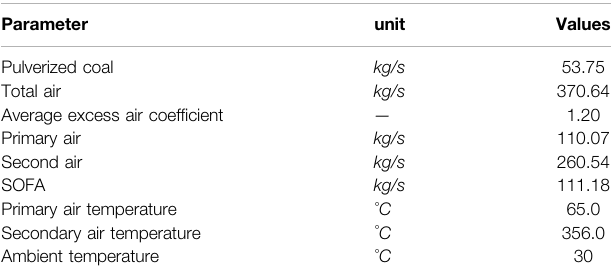
TABLE 1 | Main boiler operating parameters at the rated